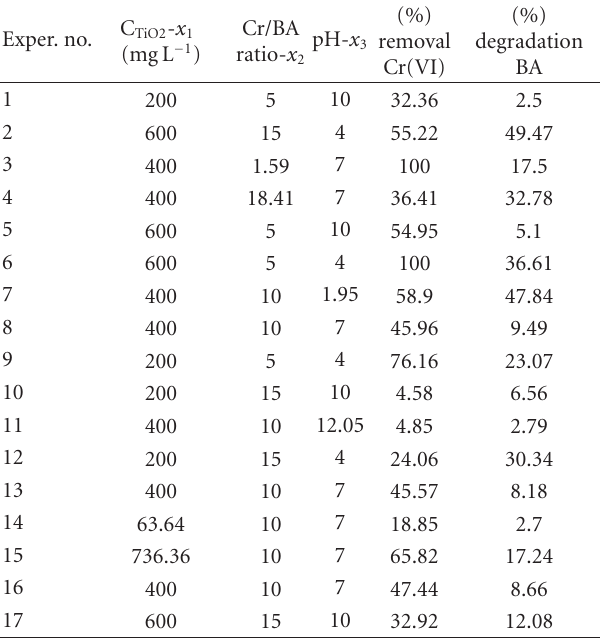
Table 1: Central composite design matrix and experimental results for benzoic acid (BA) and Cr(VI) photocatalytic degradation. Exper.